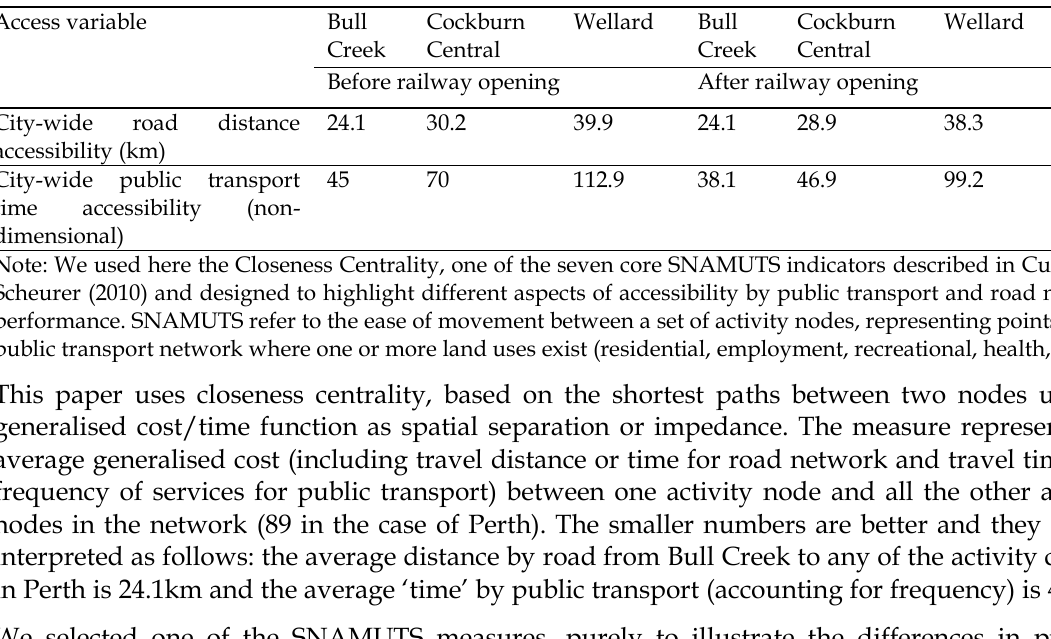
City-wide access by